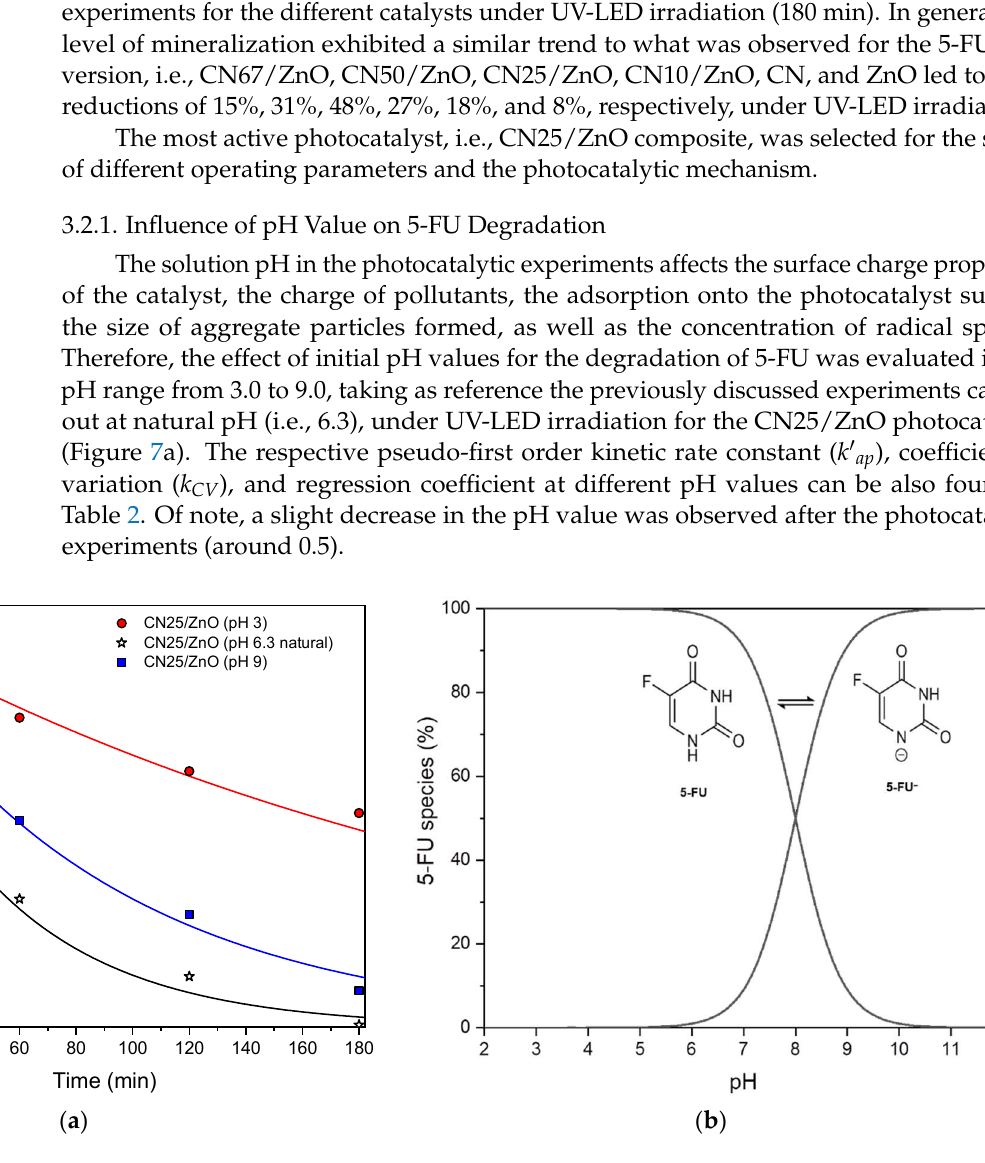
Figure 7. ( a ) Normalized concentration of 5-FU as a function of time pH values of 3.0, 6.3 (natural pH), and 9.0 for CN25/ZnO. ( b ) The 5-FU species distribution diagram as a function of pH.